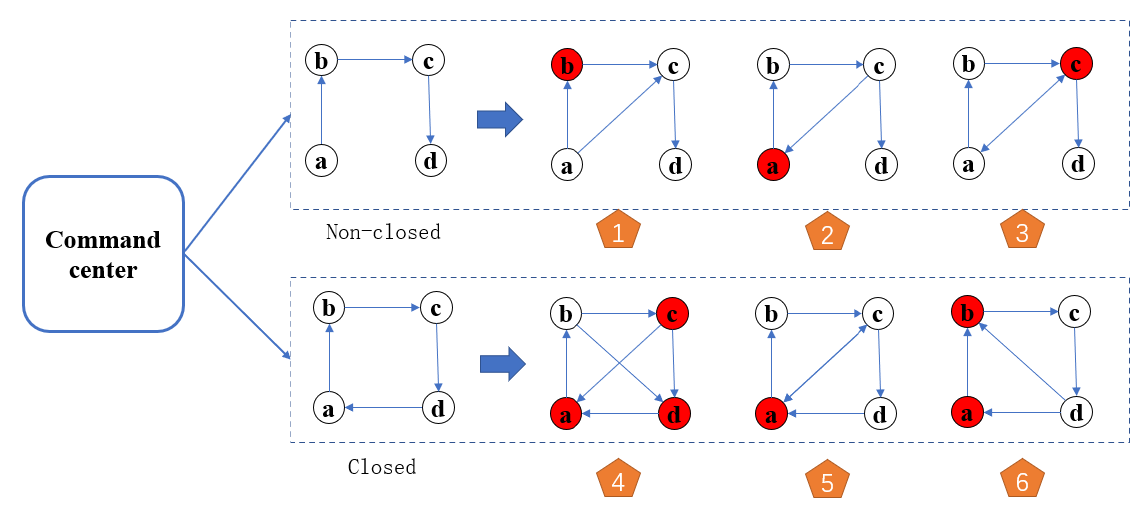
Figure 4. The motif evolution